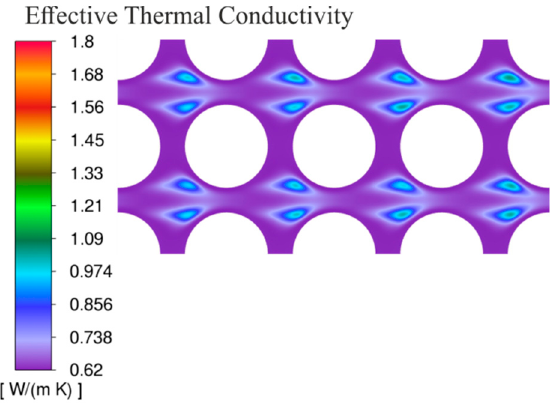
Figure 16. The effective thermal conductivity contour plots for the three central rows of the tube bundle at a steady flow.